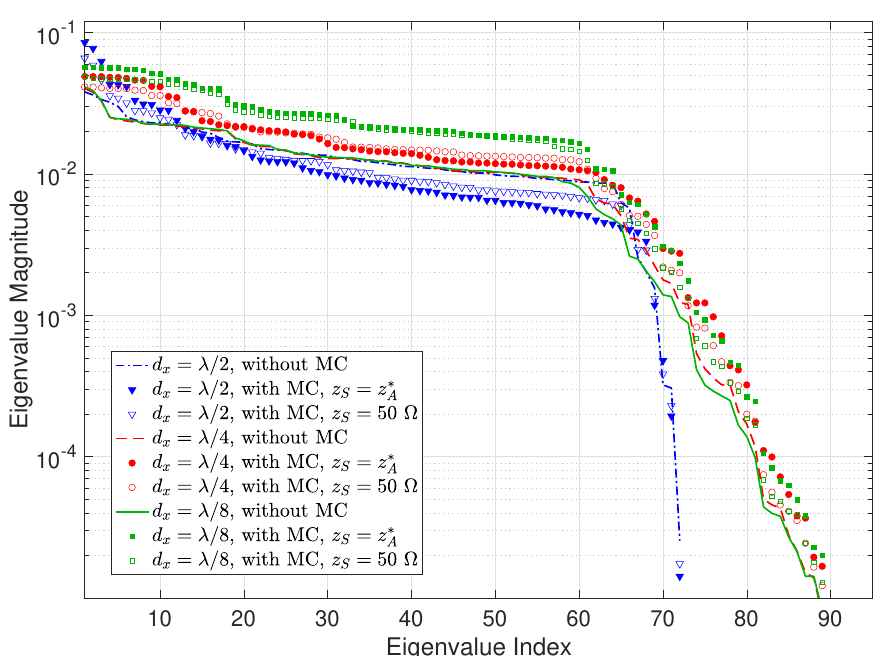
Figure 8. Eigenvalue magnitude versus eigenvalue index of the effective Tx spatial correlation matrix for horizontal element spacings of λ /2, λ /4, and λ /8 with a holographic RIS size of 4 λ × 4 λ , for both without and with MC cases. z S denotes the source impedance. Note that both the eigenvalue index and eigenvalue magnitude are